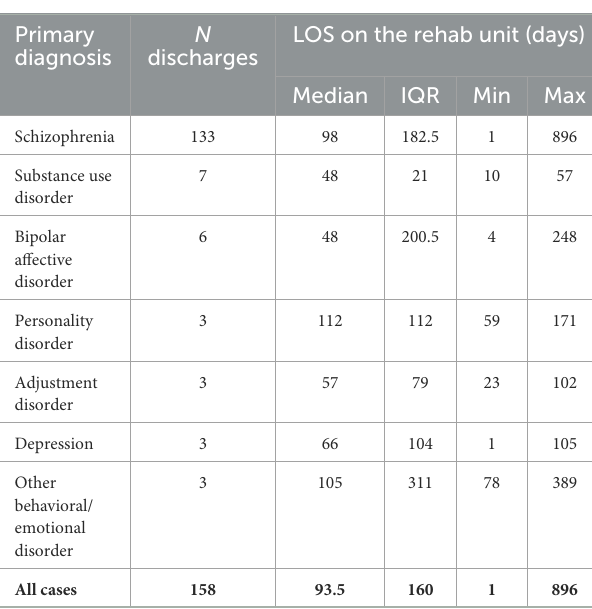
TABLE 2 Length of stay in the rehabilitation unit as per the primary